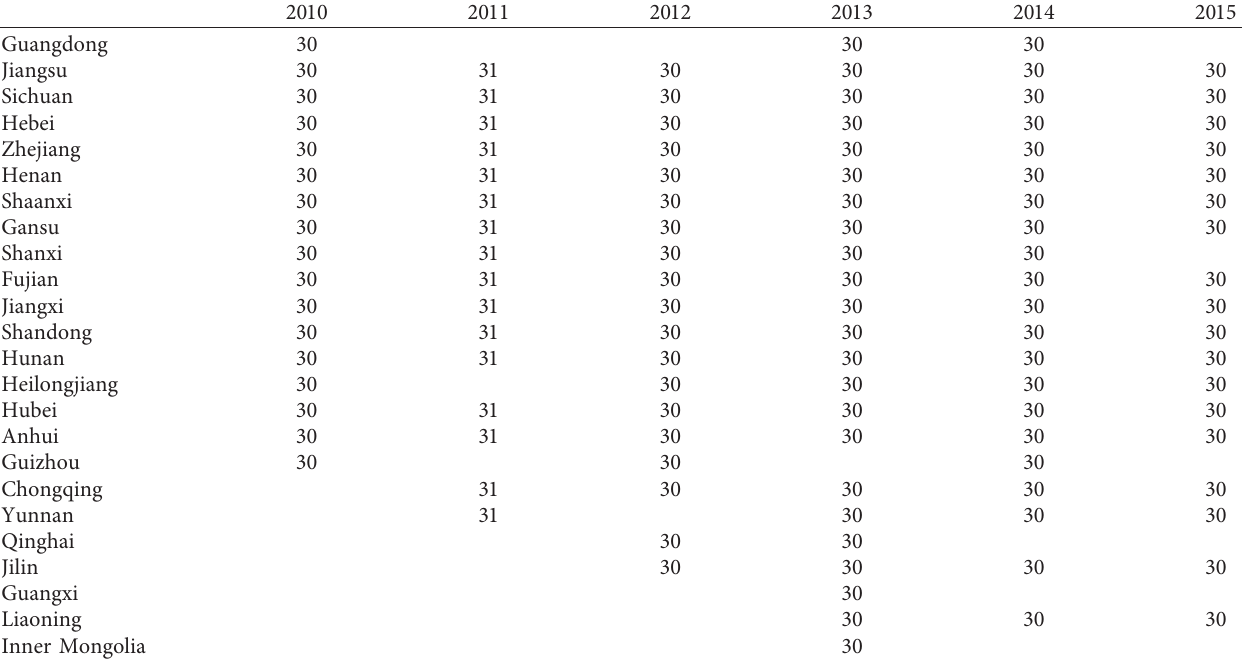
Table 2: The top 5 provinces for population outflow diversity in 2010–2015.